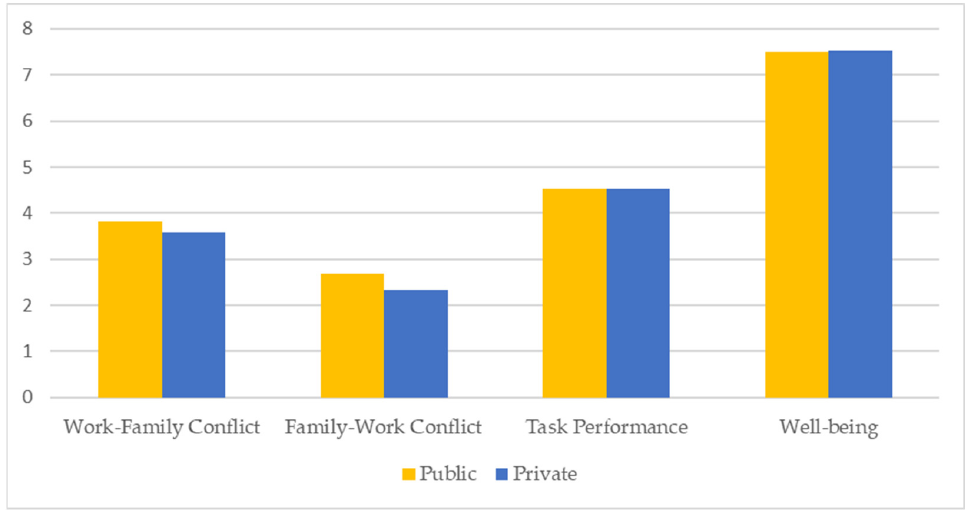
Figure 8. Distribution of variables according to sector (public and private).